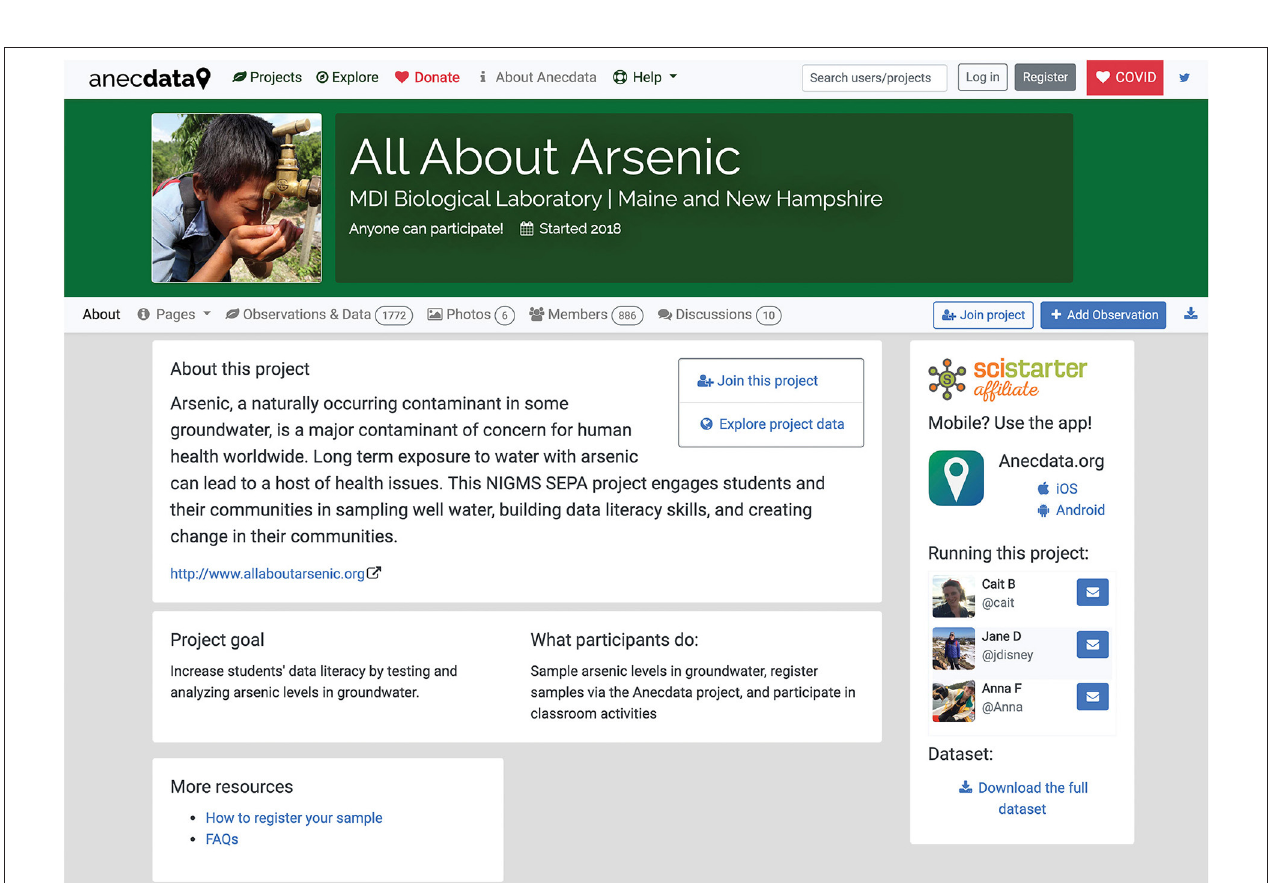
FIGURE 2 | A typical project page on Anecdata describes the project and the project goals and provides instructions to participants. In the case of “All About Arsenic,” more details about the project are provided in a link to the project website.